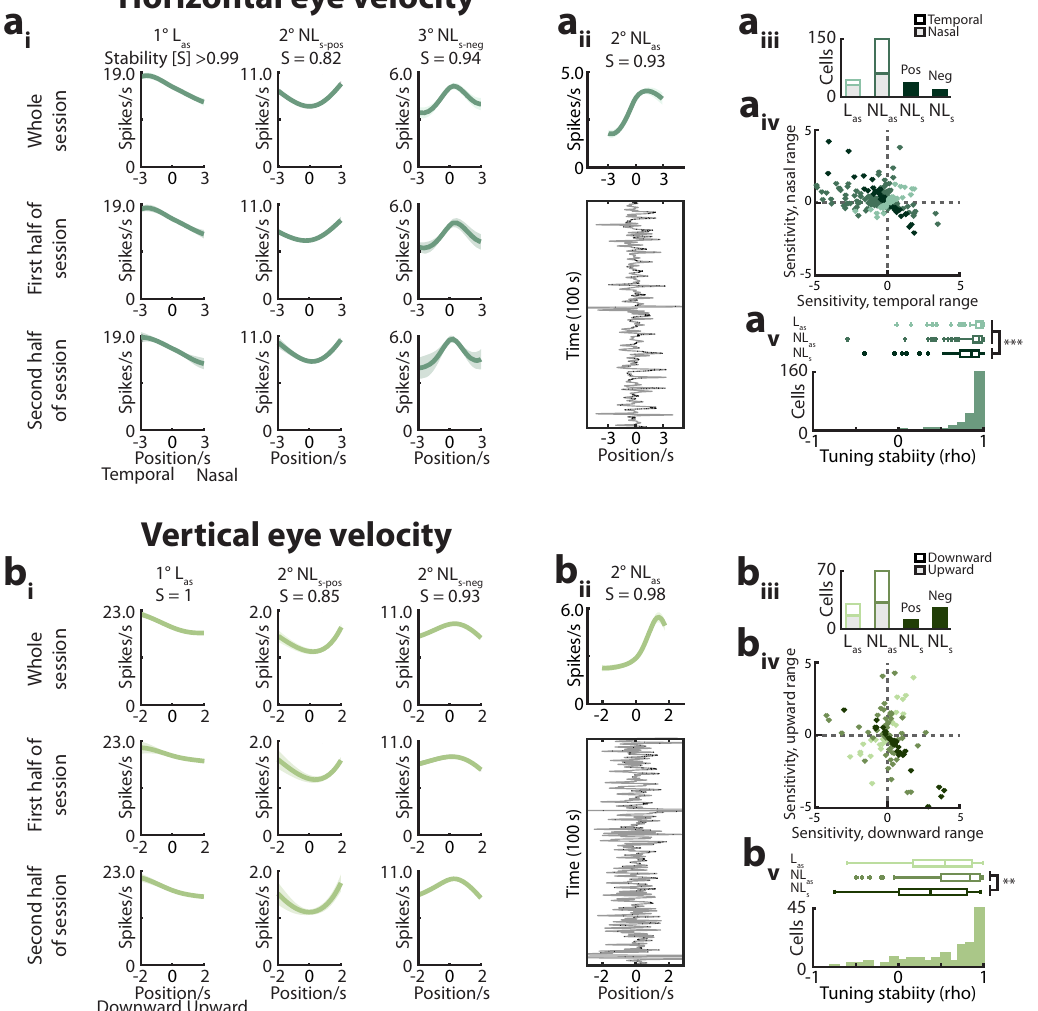
Fig. 6 Heterogenous tuning to eye velocity. a i Model-derived tuning curves (mean ± sem of 10 model folds) for cells signi fi cantly encoding horizontal eye velocity ( _ E h ; Supplementary Figs. 5 – 8). The stability ( “ S ” ) and tuning curve class is indicated at top (L as , linear-asymmetric; NL as , nonlinear-asymmetric; NL s , nonlinear-symmetric; Pos, positive; Neg, negative). a ii Bottom: Spiking from an _ E h -encoding cell. Gray trace, E h . Black dots, spikes. Top: The associated tuning curve. a iii Summary tuning curve classes. Bar color indicates nasal/temporal preference. a iv Cells ’ sensitivity in the temporal versus nasal rotational ranges. Units = spikes/s/normalized eye width/s. a v Stability of tuning to _ E h . Boxplots: linear-asymmetric and nonlinear-asymmetric cells were signi fi cantly more stable than nonlinear-symmetric cells (median [1st – 3rd quartile]; L as = 0.96 [0.91 – 0.99]; NL as = 0.94 [0.87 – 0.98]; NL s = 0.86 [0.72 – 0.93]; Χ 2 = 19.30, P = 6.4e − 5, df = 2; L as versus NL as , P = 0.12, L as versus NL s , P = 0.00028, NL as versus NL s , P = 0.00012; Kruskal – Wallis test with two-sided post hoc Wilcoxon rank-sum comparisons with α = 0.0167 after Bonferroni correction for multiple comparisons). b i Tuning curves for cells signi fi cantly encoding vertical eye velocity ( _ E v ). b ii Spiking from an _ E v -encoding cell. b iii Summary of tuning curve classes. Bar color indicates upward/ downward preference. b iv Cells' sensitivity in the upward versus downward velocity ranges. Units = spikes/s/normalized eye width/s. b v Stability of tuning to _ E v . Boxplots: nonlinear-asymmetric cells were signi fi cantly more stable than nonlinear symmetric cells (median [1st – 3rd quartile]; L as = 0.55 [0.18 – 0.87]; NL as = 0.85 [0.51 – 0.96]; NL s = 0.38 [0.02 – 0.81]; Χ 2 = 11.37, P = 0.0034, df = 2; L as versus NL as , P = 0.048, L as versus NL s , P = 0.33, NL as versus NL s , P = 0.0014; Kruskal – Wallis test with post hoc two-sided Wilcoxon rank-sum comparisons with α = 0.0167 after Bonferroni correction for multiple comparisons). Boxplots: box, interquartile range; solid line, median; whiskers, range; outliers plotted